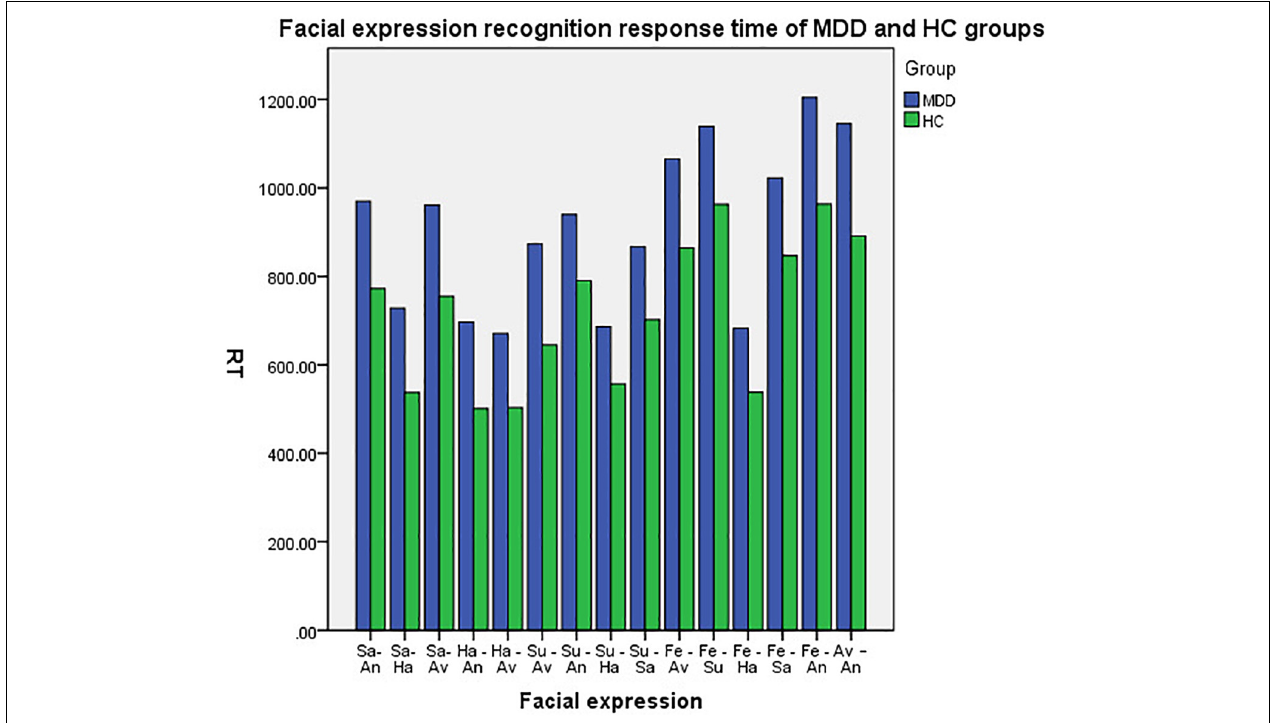
FIGURE 3 | Facial expression recognition response time of MDD and HC groups.